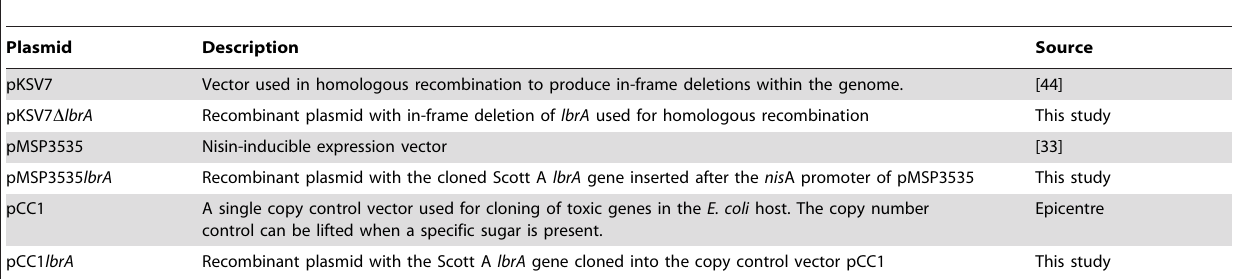
Table 2. Plasmids used in this study.